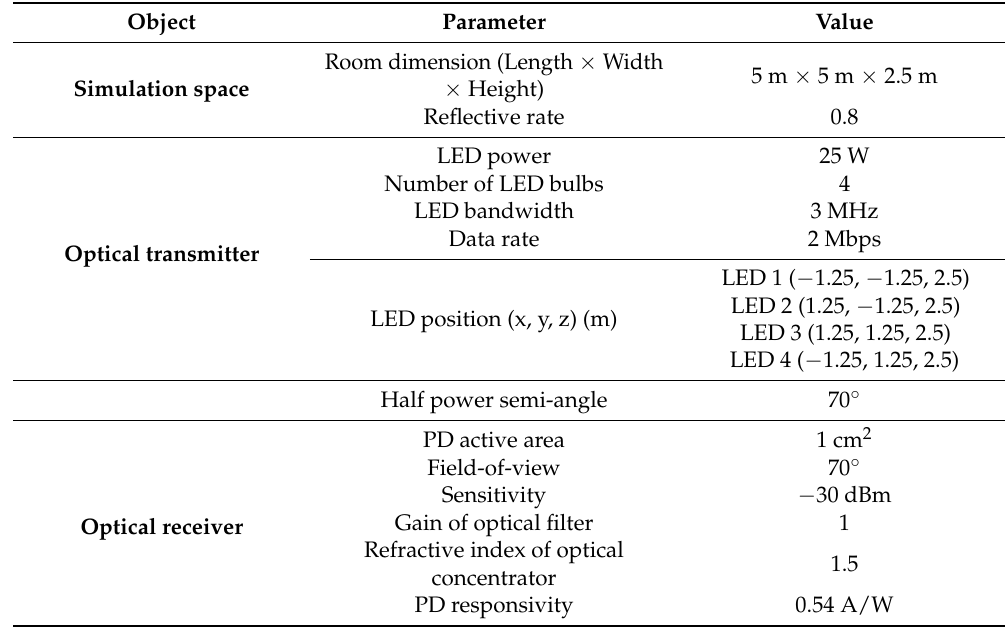
Table 1. Visible Light Communication (VLC) parameters.